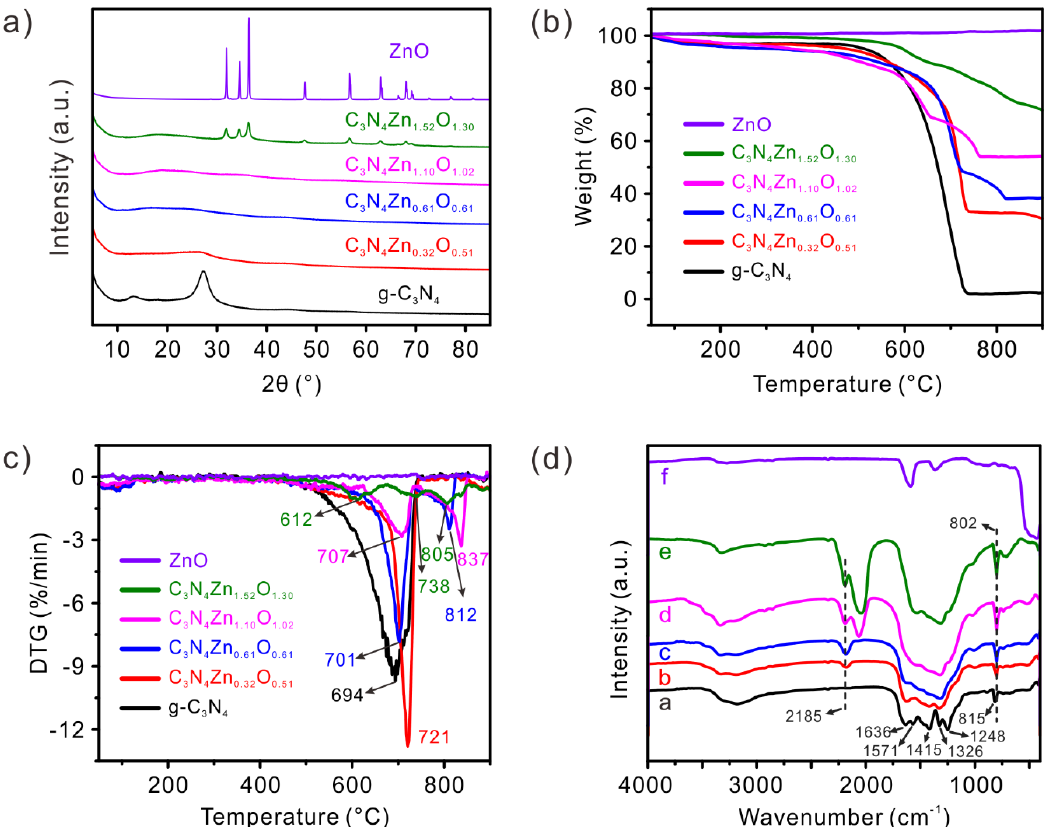
Figure 1. ( a ) XRD patterns, ( b ) Thermogravimetric analysis (TGA) curves, and ( c ) DTG curves of